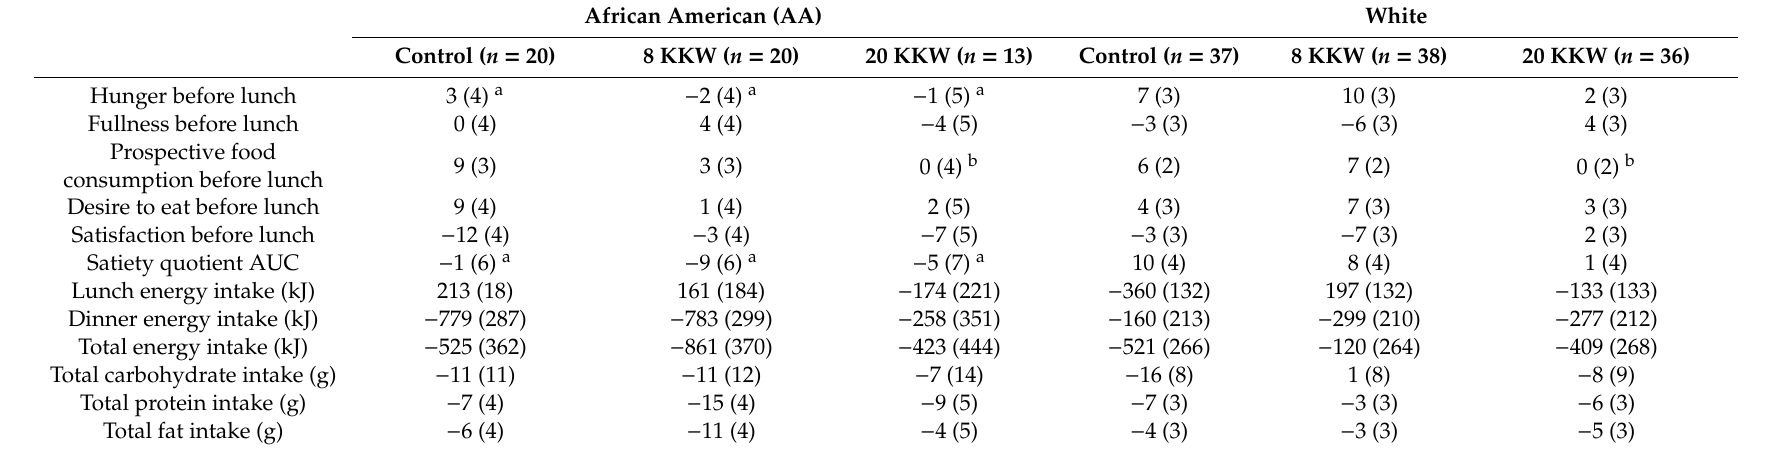
Table 2. Changes in subjective appetite and food intake in response to the 24-week intervention in Africans Americans and Whites. African American (AA) White Control ( n = 20)